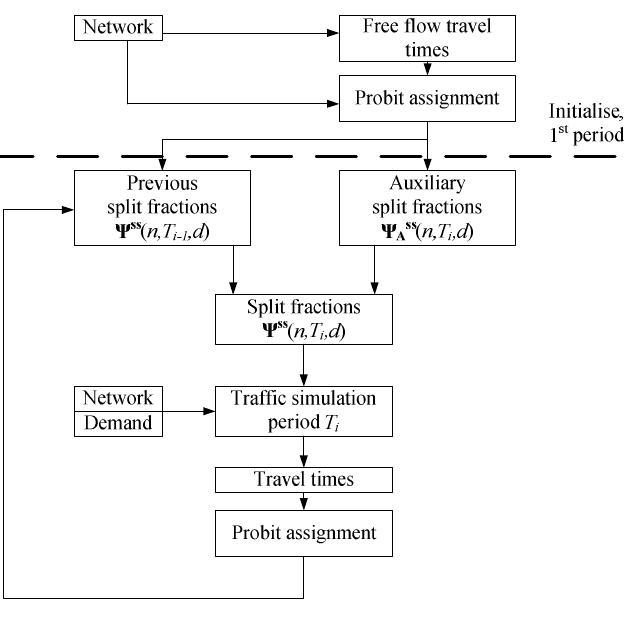
Figure 3. The route choice